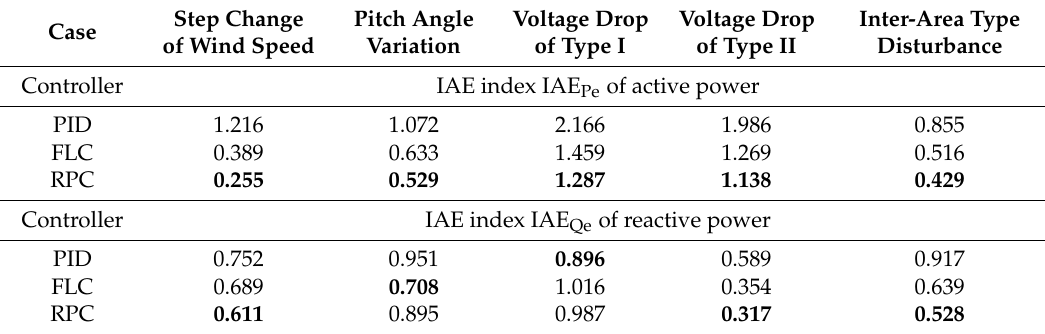
Table 2. IAE indices of different controllers obtained in different scenarios (p.u.).